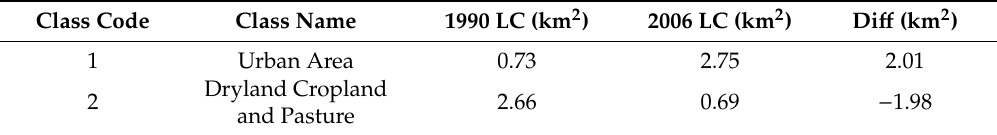
Table 4. LCLU changes between 1990 and 2006 in the first selected sub-basin (sub-basin